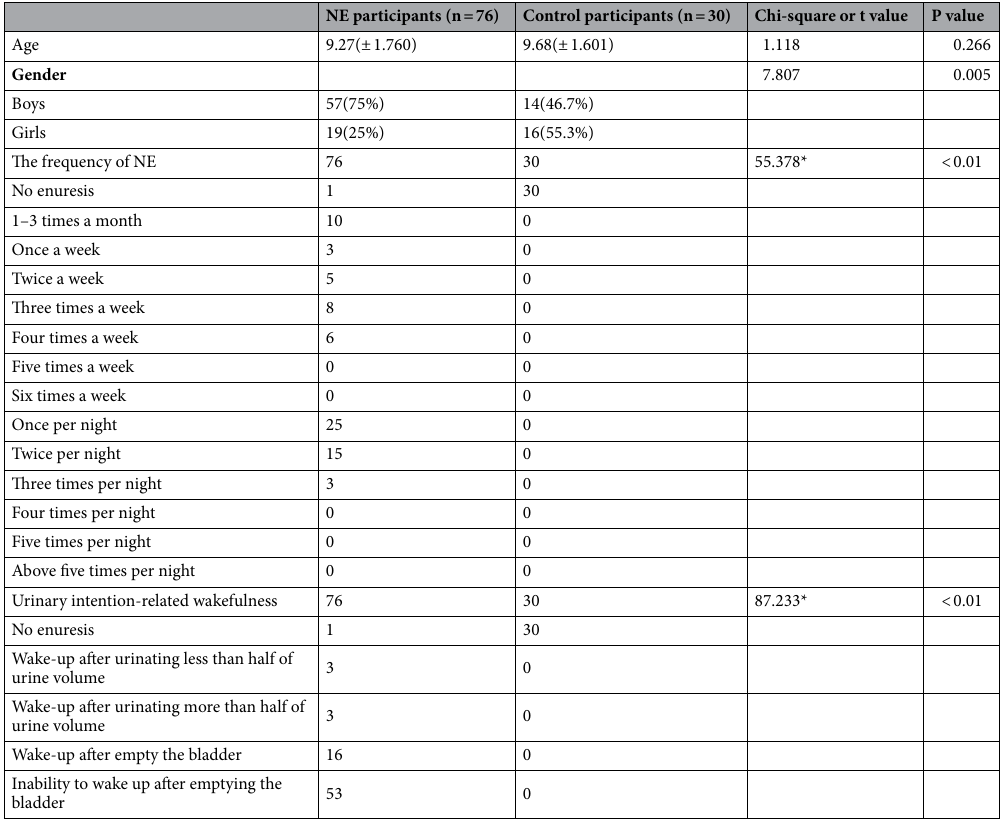
Table 1. Demographic data of the study participants. *The result came from Mantel–Haenszel test.